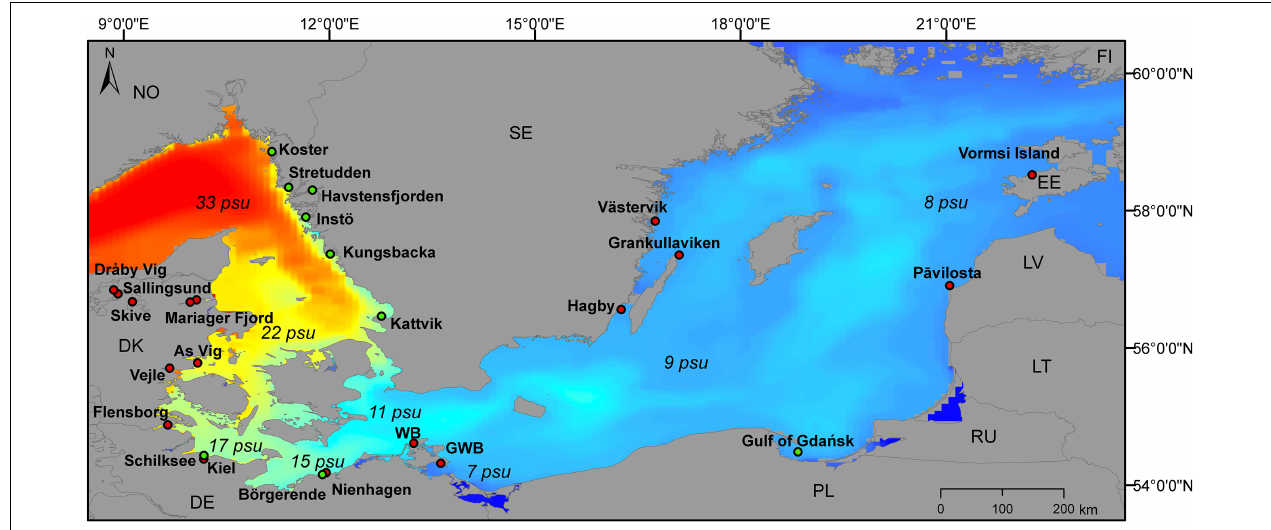
FIGURE 1 | Sampling sites along the Baltic Sea coast. Red circles indicate samples from longline collectors (in the water column), green circles indicate sampling from wild stocks (off the ground).